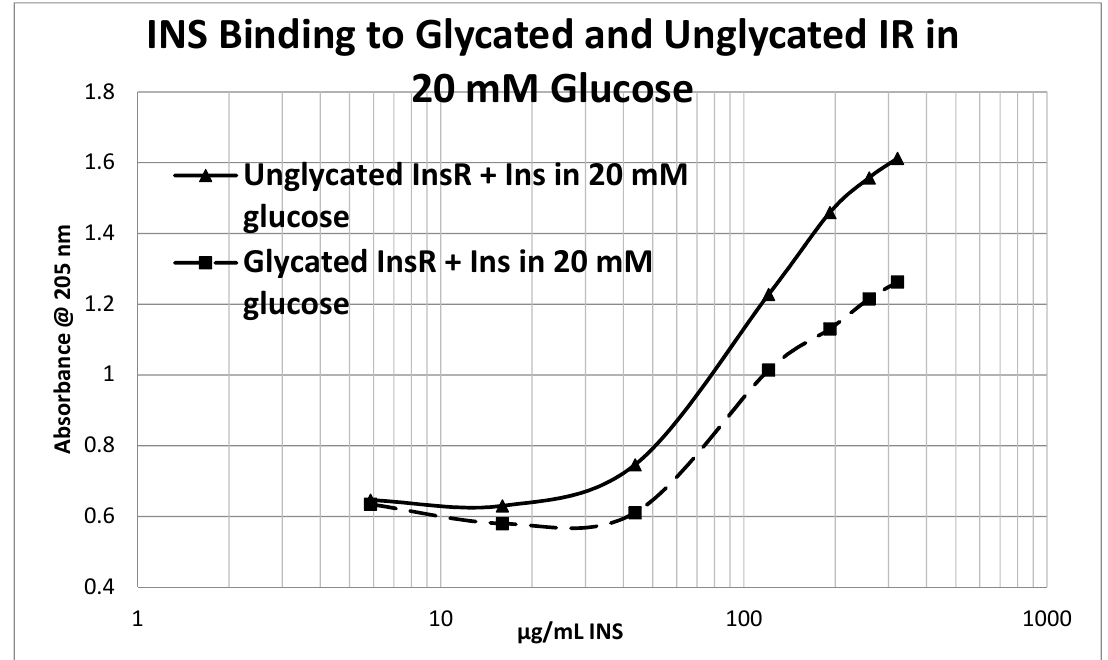
Figure 13. Insulin (INS) binding to glycated and unglycated insulin receptor (InsR) in phosphate buffered saline with 20 mM glucose. The binding constant of the INS for InsR under these conditions was found to be 110 µg/mL of INS (compared with 70 in the absence of glucose; see Figure 12A). Glycation reduced the amount of binding by almost exactly one third without appreciably altering affinity. Int. J. Mol. Sci. 2017 , 18 , 2602